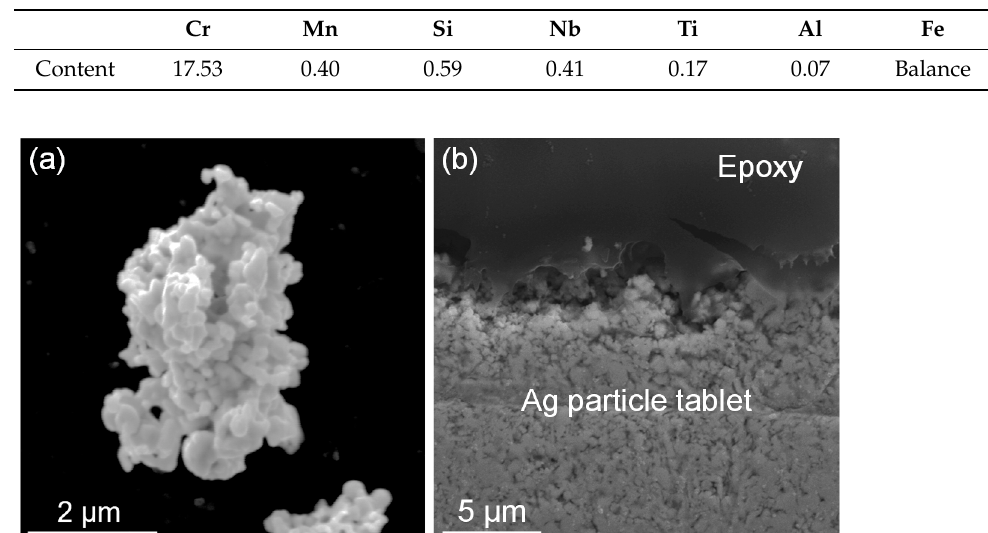
Figure 1. ( a ) Morphology of the Ag powder and ( b ) morphology of the Ag particle tablets. Table 1. Composition of the AISI 441 stainless steel (wt.%).